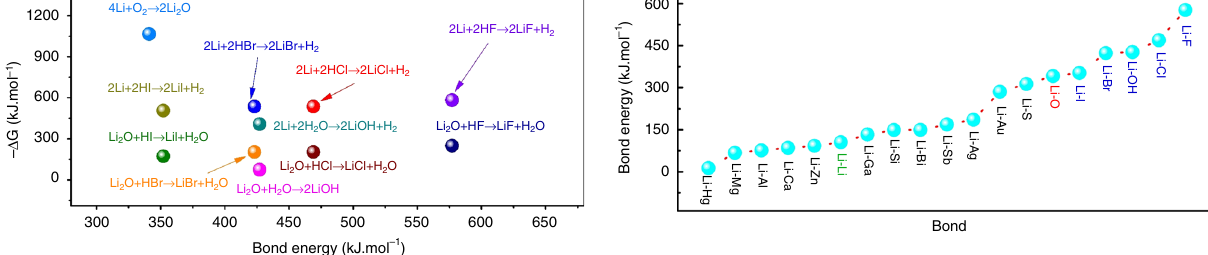
NATURE COMMUNICATIONS| (2019) 10:4930